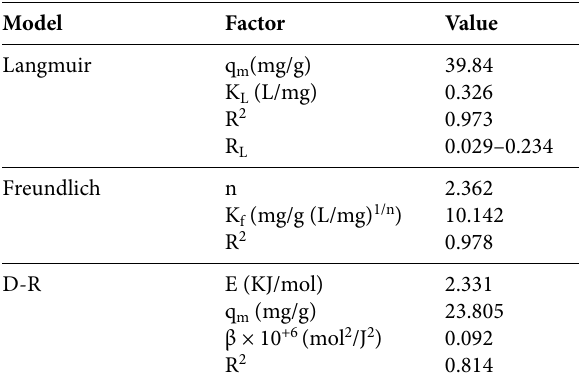
Table 2. Parameters of P ions sorption isotherms using MnFe 2 O 4 nanoparticles Model Factor